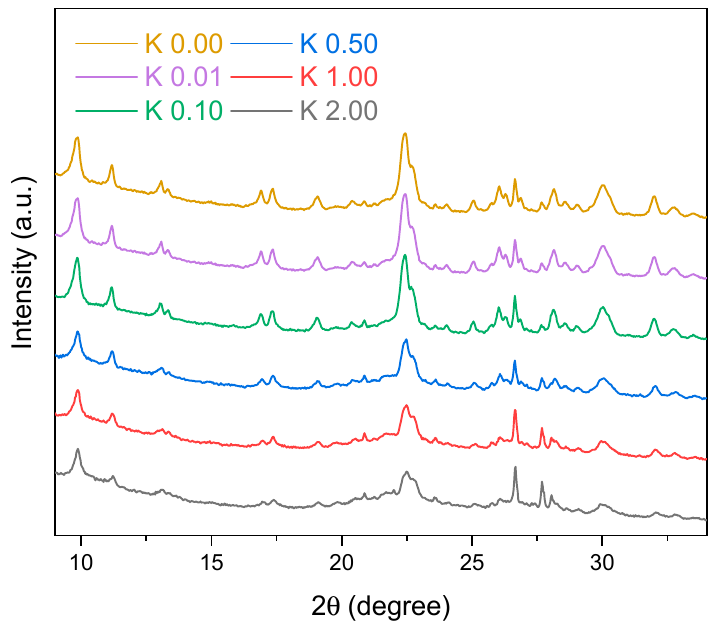
Figure 2. XRD diffractograms of neat and modified clinoptilolite.